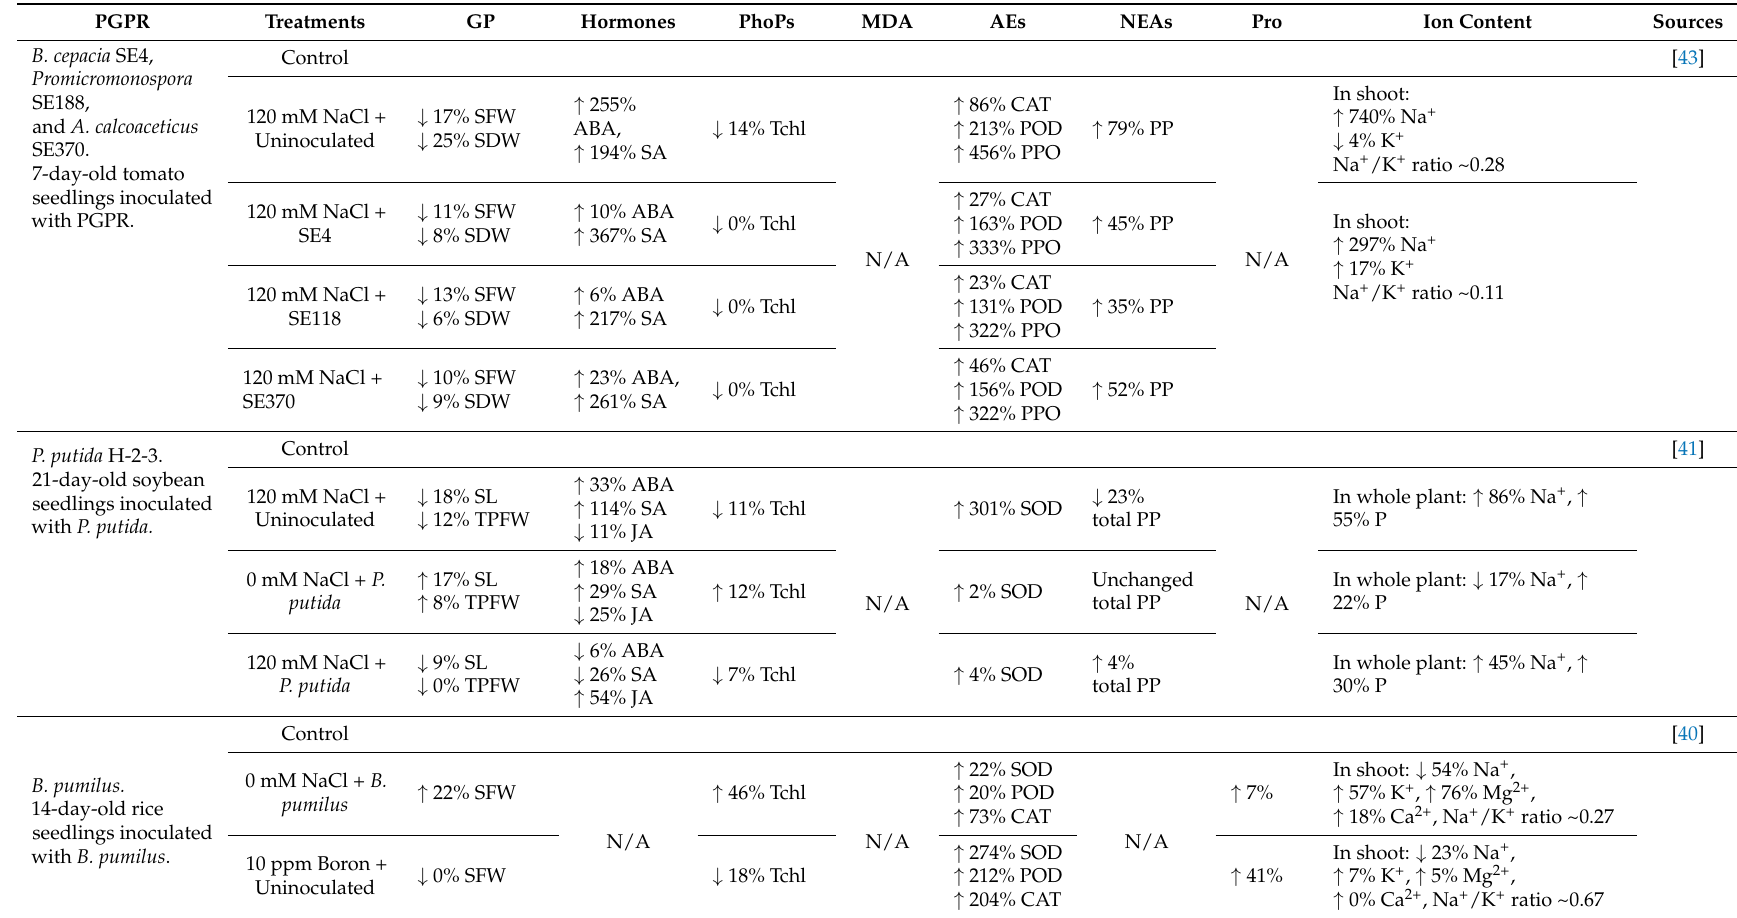
Table 1. Ameliorative effects of plant growth-promoting rhizobacteria (PGPR) on plant growth and physio-biochemical parameters under salinity conditions.